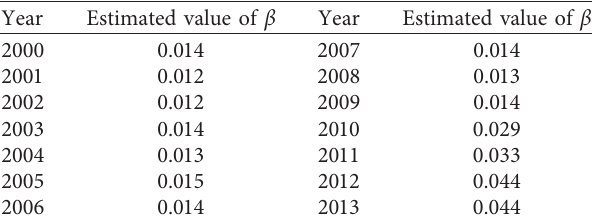
Table 2: Estimating parameter β using the impedance function.